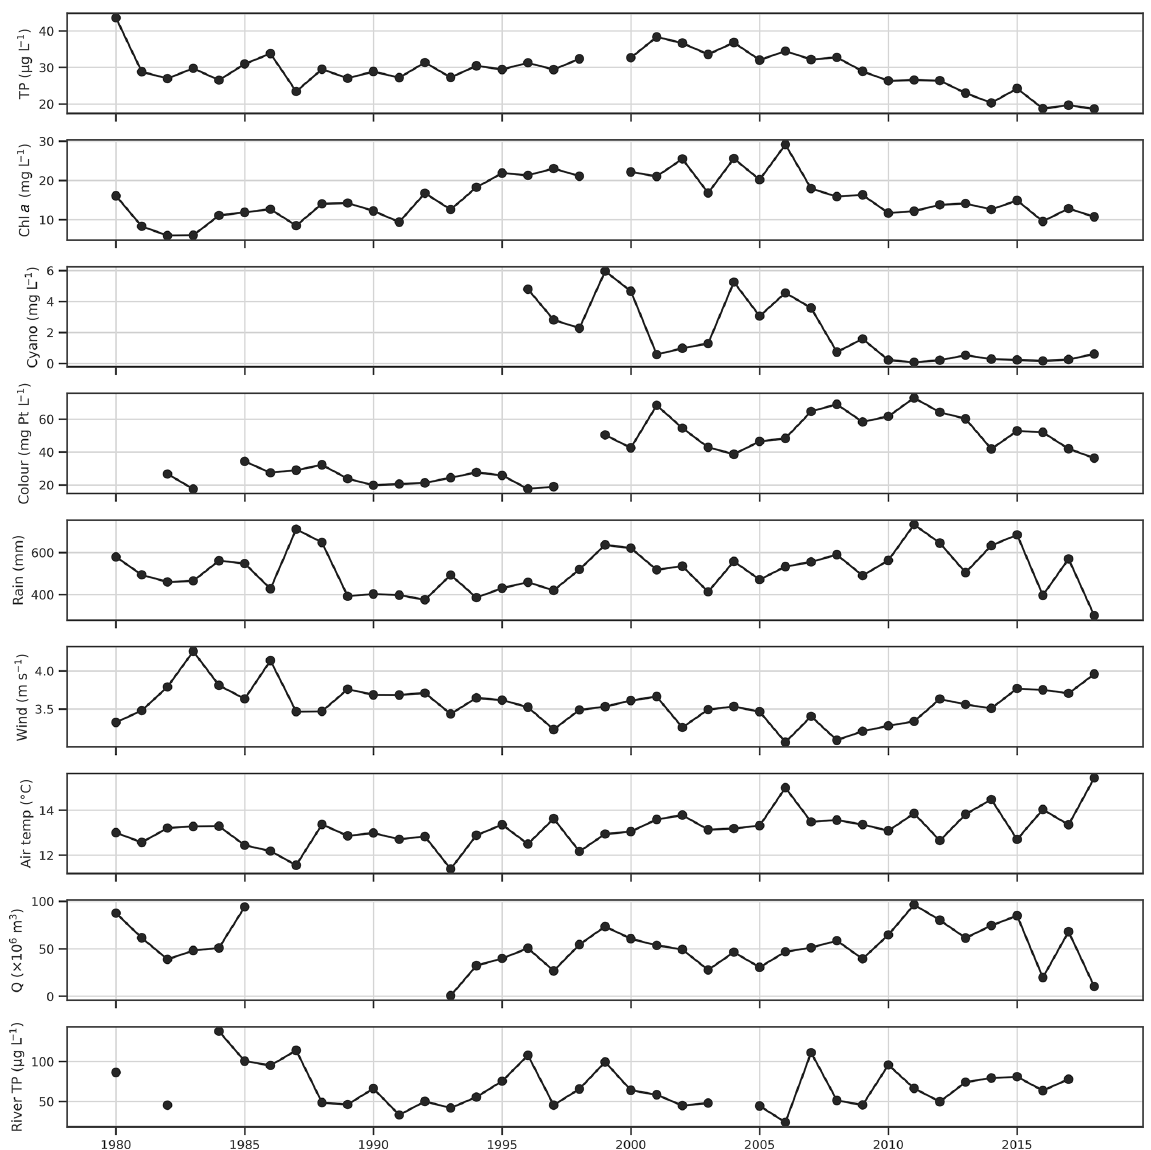
Figure 2. Time series of growing season (May–October) mean lake chl a , total phosphorus (TP) and colour, seasonal maxima of cyanobacte- ria biovolume, seasonal mean wind speed, air temperature and Hobøl River TP concentration, and seasonal sums of rainfall and discharge ( Q